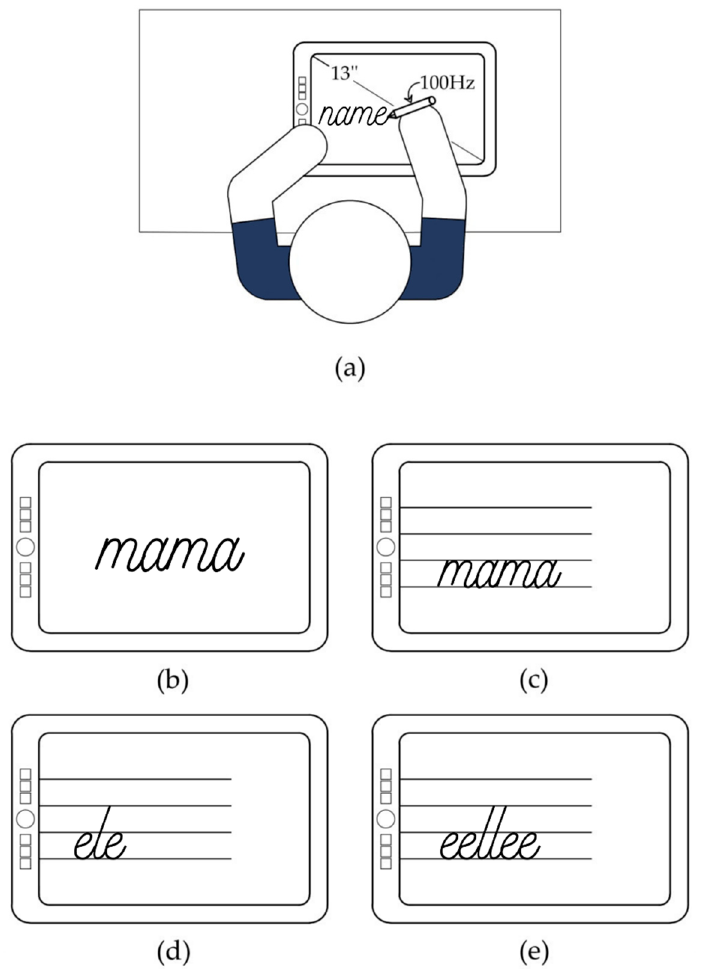
Figure 4. MovAlyzeR test of pen pressure. ( a ) Each participant took the test on a horizontally positioned graphics tablet with an electronic pen measuring pressure. Firstly, a student wrote his or her name twice as training ( b – e ); then, there were eight test trials consisting of performing four tasks twice: writing the word “mama” (the Polish equivalent of the English word “mom”) on a blank screen, writing the word “mama” in lines, writing the pseudo ‐ word “ele” in lines, and writing the pseudo ‐ word “eellee” (also in lines). During the whole test, participants used only their dominant hand.